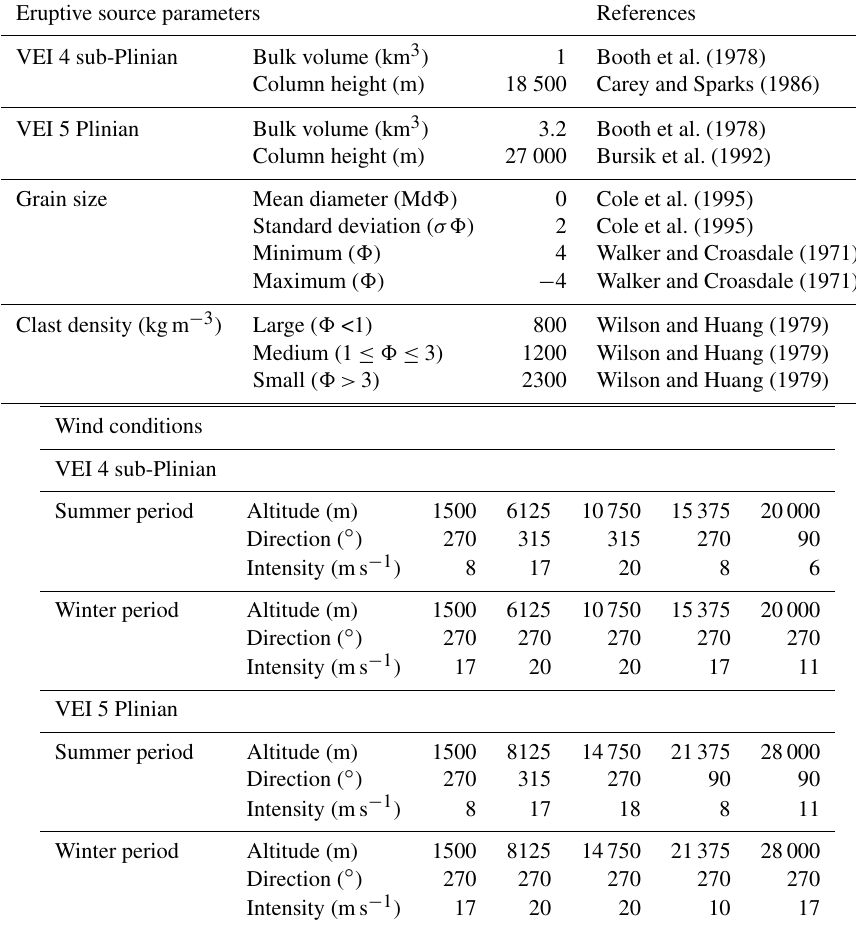
Table 1. Input parameters used for the simulations of VEI 4 sub-Plinian and VEI 5 Plinian eruptions. Eruptive source